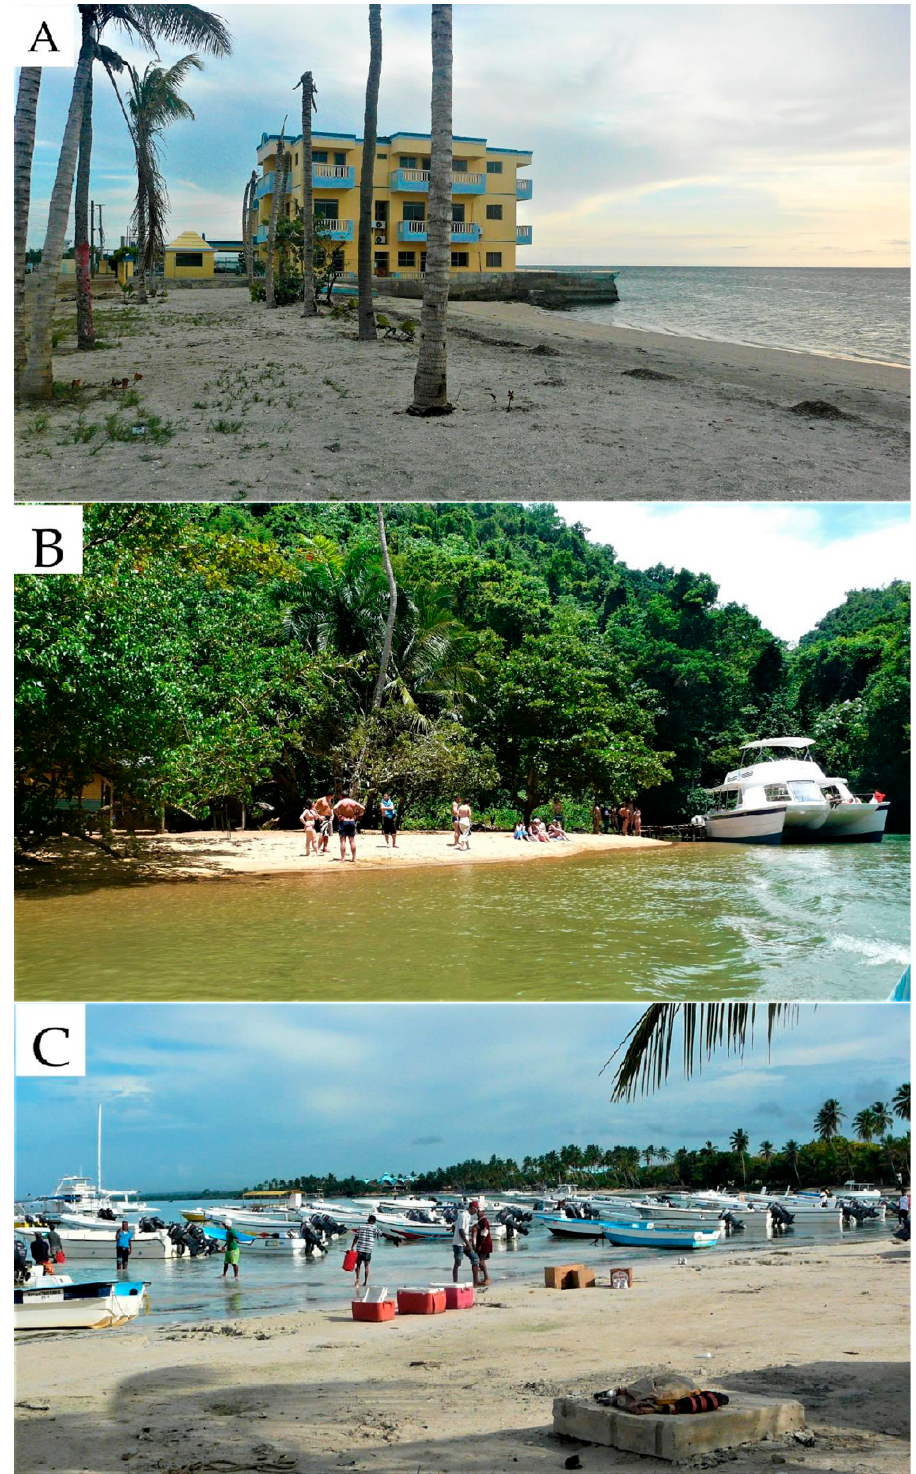
Figure 4. The pictures show different national parks. ( A ) Construction without planning permission in Montecristi National Park. ( B ) Uncontrolled access by tourists in Los Haitises National Park. ( C ) High concentration of boats for tourism in Del Este National Park.